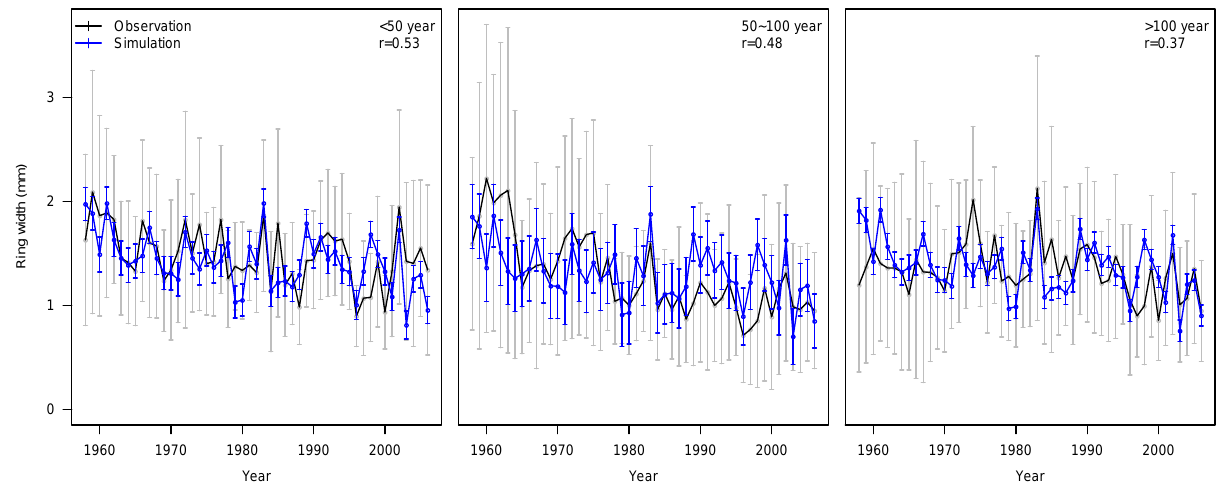
Figure 3. Comparison between simulations and observations for the three age cohorts (young: 0–49 years; mature: 50–99 years; old > 100 years). Each tree was initialised at its actual diameter at 1958, calculated from the measured diameter in 2007, and measured radial growth between 1958 and 2007. The black line is the mean of observations within each age cohort, and grey bars are the standard deviation (SD) of individuals within each age cohort. The blue lines and bars are the mean and standard deviation from the